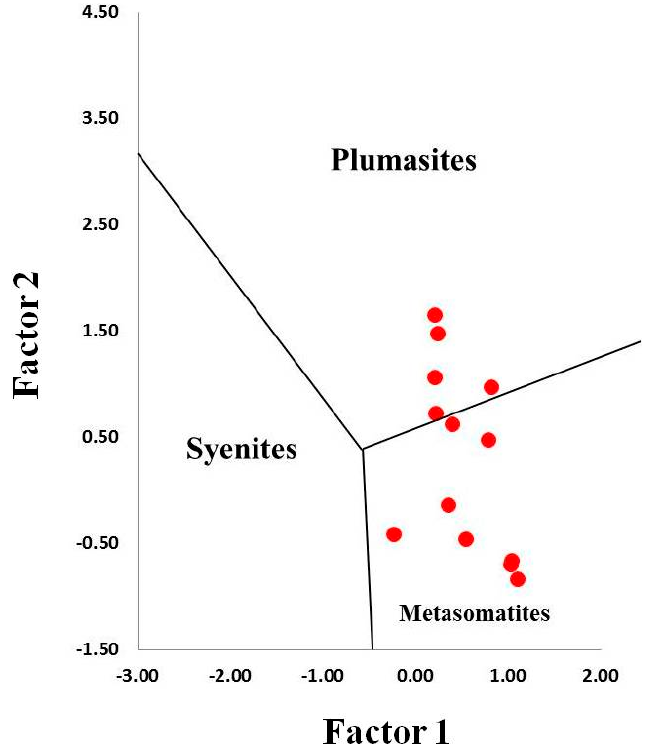
Figure 11. Discriminant factor diagram for identification of sapphire origin modified after Giuliani et al. (2014) [40].